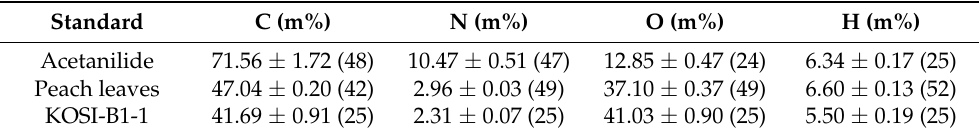
Table 2. Elemental concentrations of C, N, O and H of the three standards used in the elemental analysis (mean ± sd), with replicate number n in